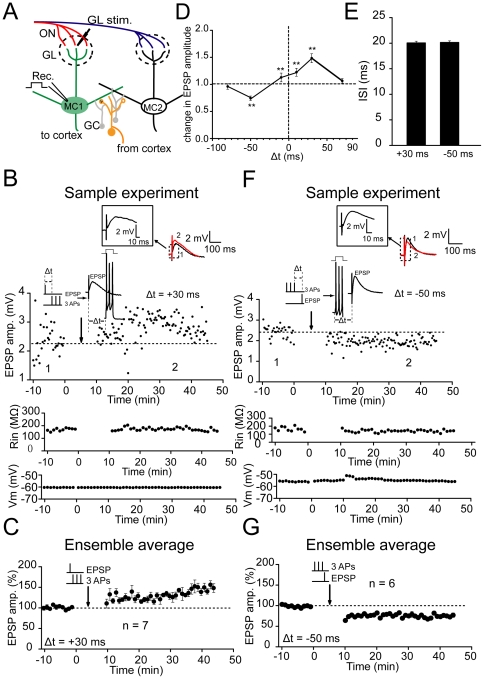
STDP of excitatory olfactory sensory inputs to MCs.(A) Schematic of experimental configuration. Whole-cell recording of a single MC during the application of an extracellular stimulation in an associated glomerulus (the upper dotted line circle) that activated presynaptic excitatory sensory inputs. (B) Potentiation of EPSPs in MCs by a +30 ms pairing (Δt = +30 ms, repeated 60 times). The induction protocol for LTP is depicted on top of the arrow. An EPSP evoked by an extracellular stimulation was paired with a short burst of three APs at 50 Hz elicited by current injections into the postsynaptic cell. The depicted pairing protocol resulted in the potentiation of the EPSP amplitude. The EPSPs averaged at the indicated times are shown on top of the graph. (C) Summary of the changes in the EPSP amplitude following a +30 ms pairing protocol (n = 6; p<0.001). (D) STDP plot showing the critical time window for synaptic potentiation and depression of excitatory sensory inputs. The percentage of changes in the EPSP amplitude of synaptic inputs lasting 10 min after the repetitive stimulation was plotted against the time of the inputs (defined by the onset time of the EPSP relative to the onset of the first AP in the burst) [16]. ** p<0.01, compared with baseline. (E) Statistical plot showing the ISI when Δt was set to +30 and −50 ms (n = 6), respectively. (F) Depression of EPSPs in MCs by a −50 ms pairing (Δt = −50 ms, repeated 60 times). (G) Summary of the changes in EPSP amplitude following a −50 ms pairing protocol (n = 6; p<0.001).